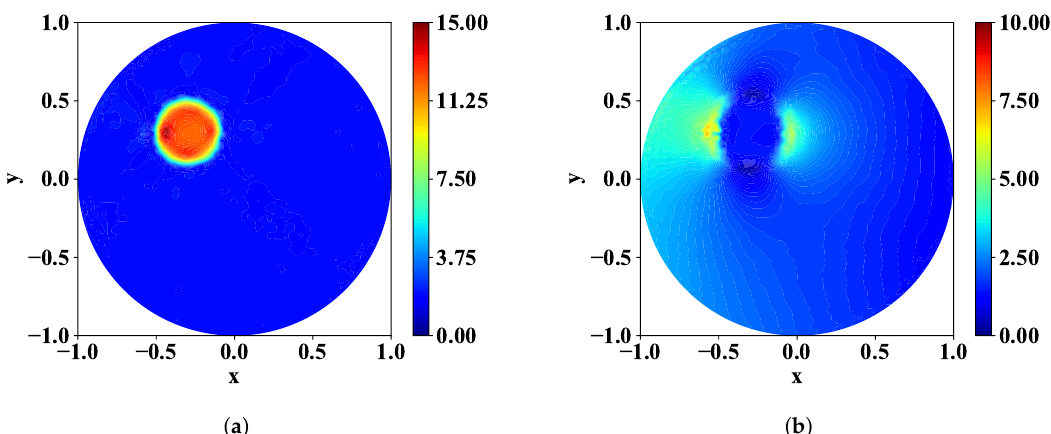
Figure 9. When SNR = 40 dB, σ = 12.0S/m and the step is 7: ( a ) the reconstructed image and ( b ) the power density.